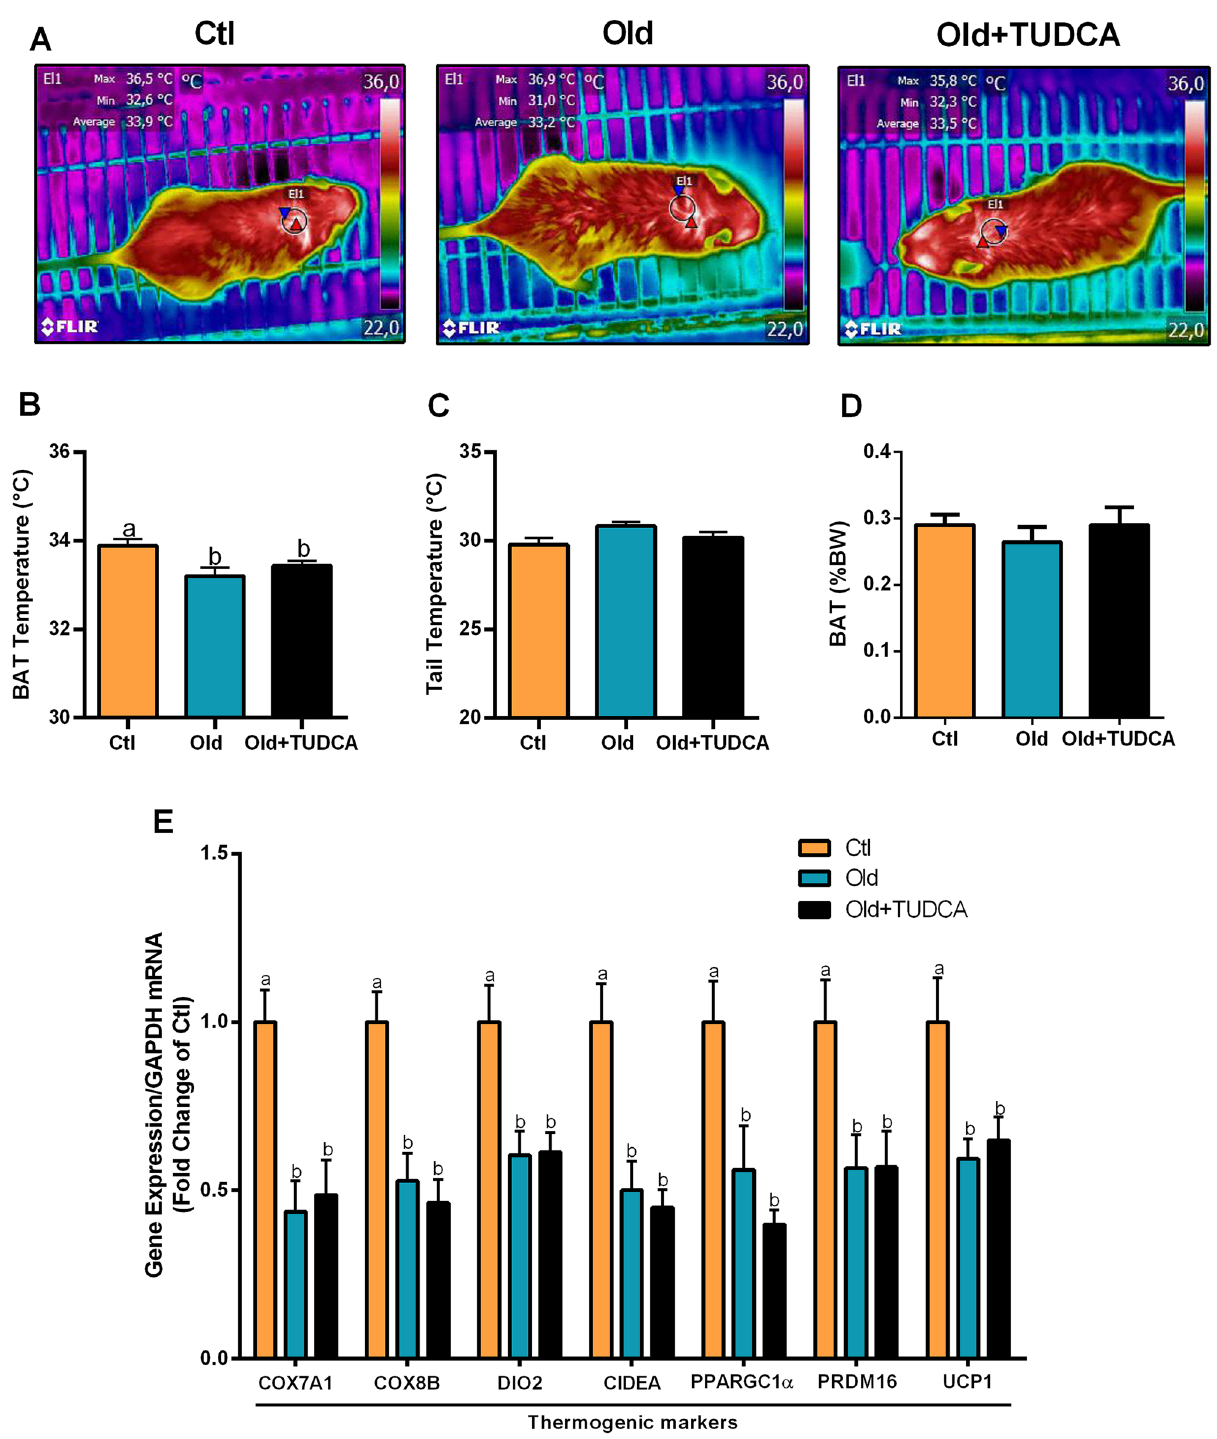
Figure 7. Effects of TUDCA treatment upon temperature and expression of thermogenesis markers in BAT. Snapshots of the dorsal region were obtained using a thermographic camera for the determination of the temperature in the region corresponding to BAT ( A , B ) and tail ( C ). Interscapular BAT fat pad weight ( D ). Real-time PCR analysis of COX7A1, COX8B, DIO2, CIDEA, PPARGC1α, PRDM16, and UCP1 ( E ), normalized by GAPDH, in BAT. Data are presented as mean ± SEM (n = 6–10). Statistical analysis was performed using the one-way ANOVA test, followed by Tukey post-hoc-test. Letters shared in common between groups indicate no significant difference. Different letters (a and b) indicate statistical difference between groups (P ≤